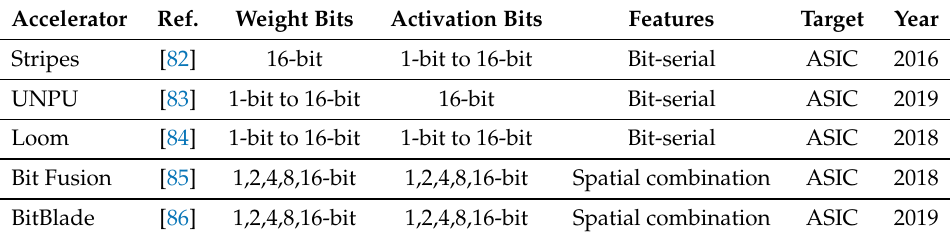
Table 3. Comparison of accelerators that support variable bitwidth